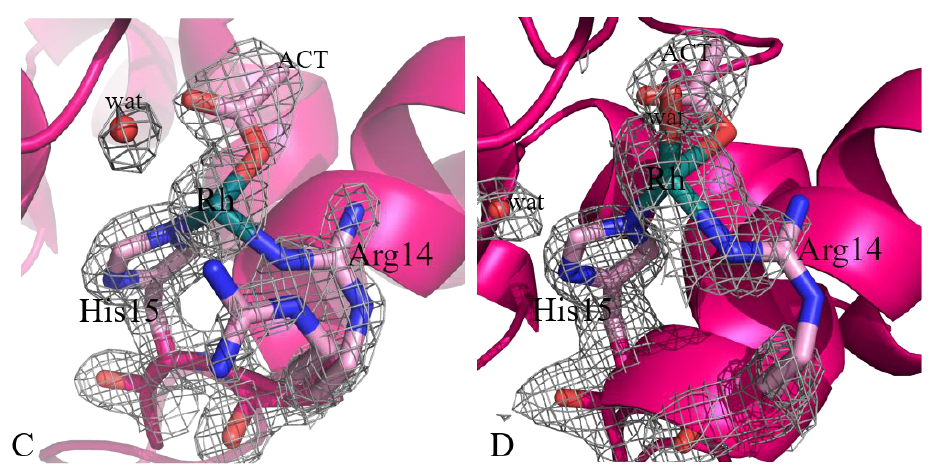
Figure 3. Details of the Rh binding site close to Arg14 and His15 in the crystals 1–4 (panels A – D , respectively). 2Fo-Fc electron density maps are contoured at 1.0 σ (grey). An example of anomalous difference electron density map of this site is reported in Supporting Information (Figure S1). Table 2. Rh binding sites found in the six structures of Rh/HEWL adducts obtained upon reaction of the protein with [Rh 2 (μ-O 2 CCH 3 ) 4 ]. Table describes the ligands at each Rh binding site. Values in parentheses refer to the occupancy of metal and ligands.* refers to atoms from symmetry related molecules.